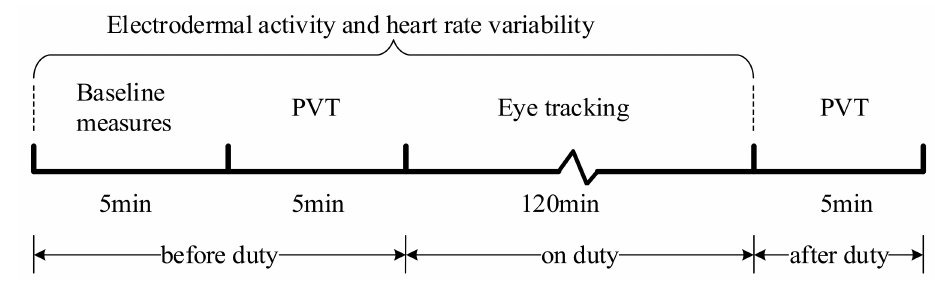
Figure 5. Experimental